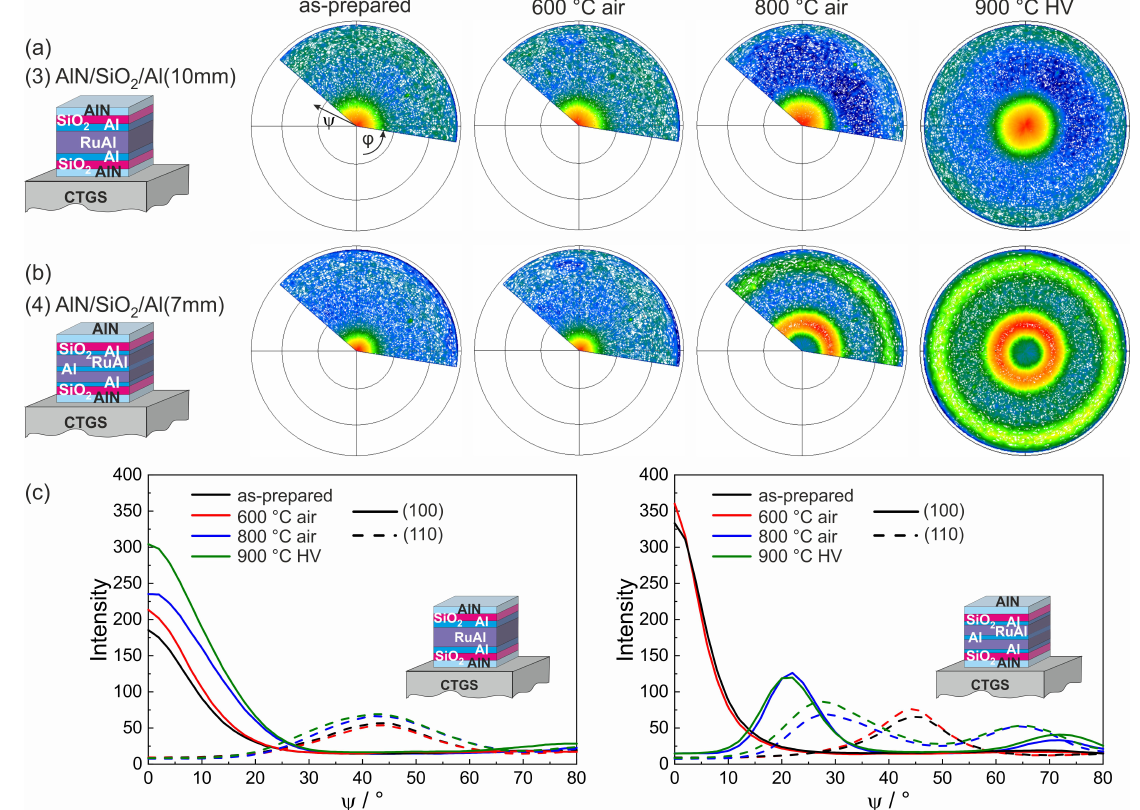
Figure 9. Pole figure measurements of the RuAl (100) pole for ( a ) the system (3)-AlN/SiO 2 /Al(10 nm) and ( b ) the system (4)-AlN/SiO 2 /Al(7 nm) on CTGS in the as-prepared state and after annealing at 600 and 800 ◦ C in air and 900 ◦ C in high vacuum. ( c ) shows the averaged intensity of the (100) and (110) pole figures dependent on the tilt angle ψ for both